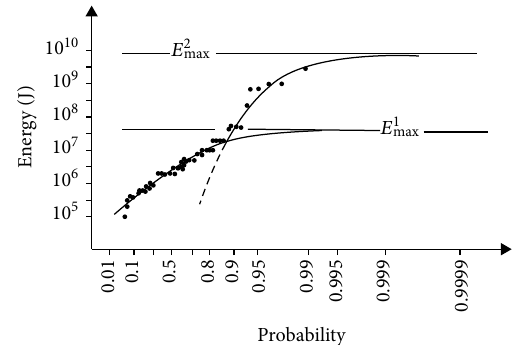
Figure 1: Probability distribution of the monthly occurrence of maximum magnitude tremors at the Lubin copper mine, Poland, for the period 1972-1980